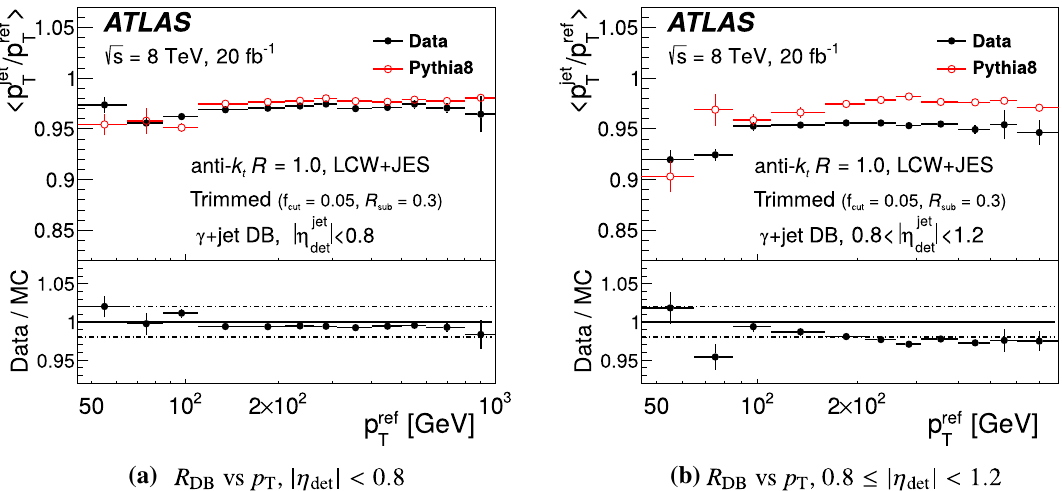
Fig. 29 R DB for trimmed anti- k t jets with R = 1 . 0 calibrated with the LCW+JES scheme for a | η det | < 0 . 8 and b 0 . 8 ≤ | η det | < 1 . 2 for both data (filled circles) and MC simulation (empty circles), as a function of the p ref